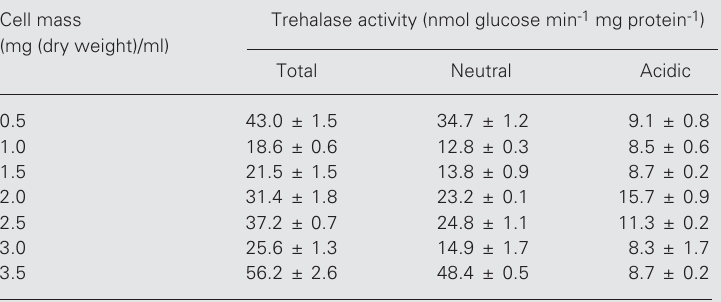
Table 3. Neutral and acidic trehalase activity during growth of Candida utilis in treha- lose.